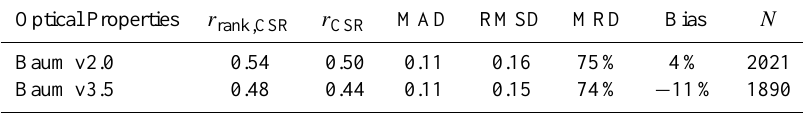
Table 2. Results of the comparison of CSR measured from ground and retrieved from SEVIRI for different setups: rank correlation r rank,CSR , Pearson correlation r CSR , mean absolute deviation MAD, root-mean-square deviation RMSD, median relative deviation MRD, bias and the number of compared data pairs N .